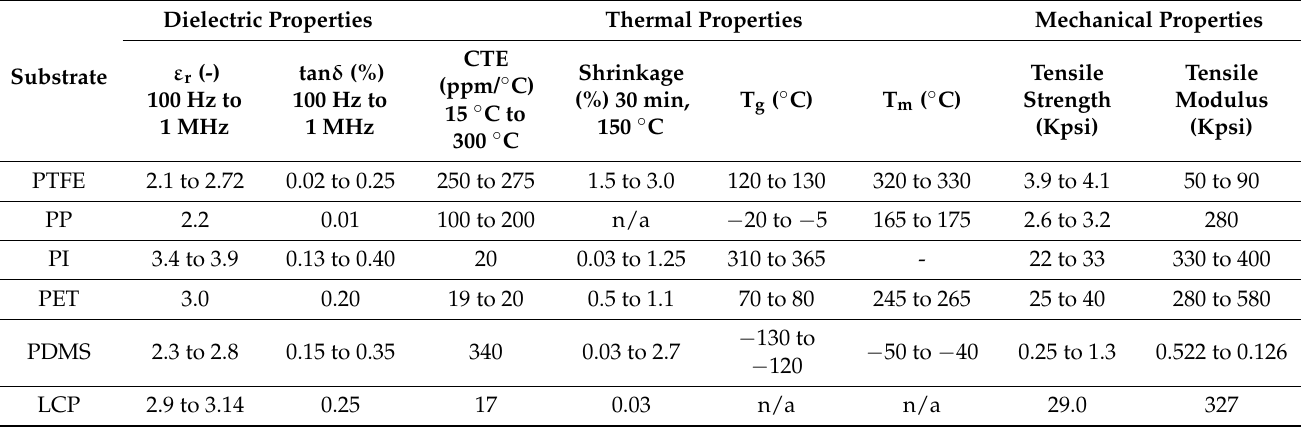
Table 1. The electrical, thermal, and mechanical properties of the most commonly used polymeric substrates